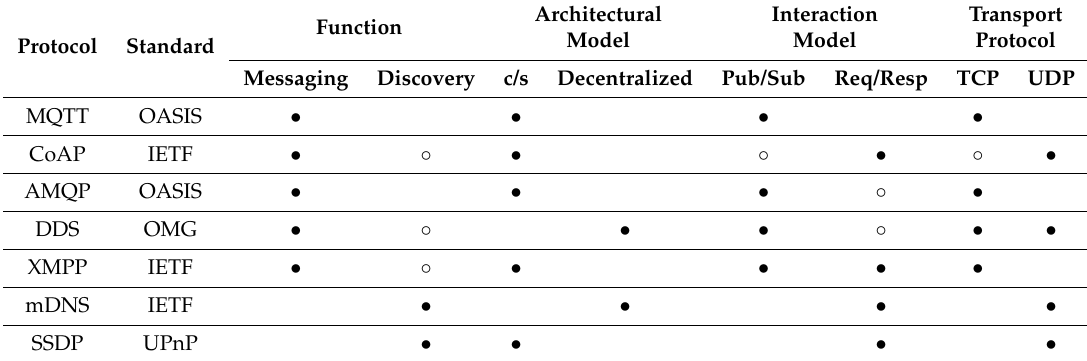
Table 1. Summary of the main characteristics of the most popular application layer protocols for IoT environments. The bullets refer to native features of the protocols, while the circles to additional features supported by the protocols.